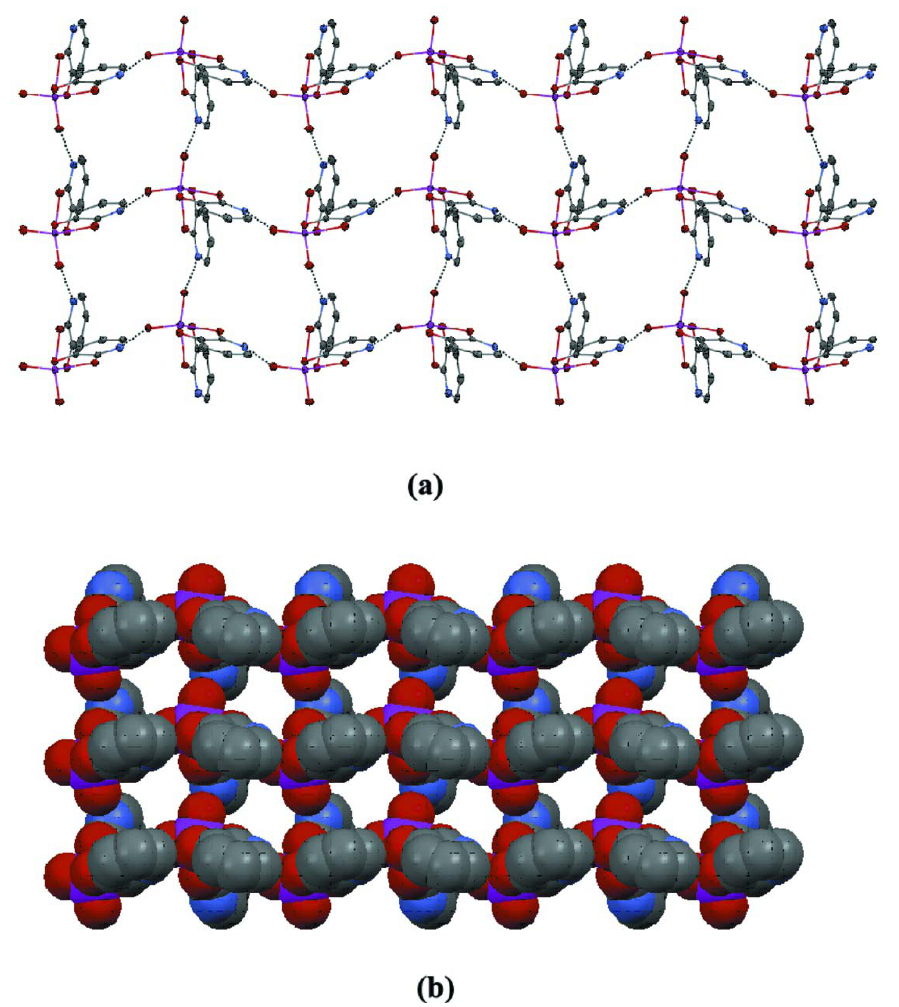
Figure 4 Views along the a axis Dioxidobis(2-oxo-1,2-dihydropyridin-3-olato)molybdenum(VI) Crystal